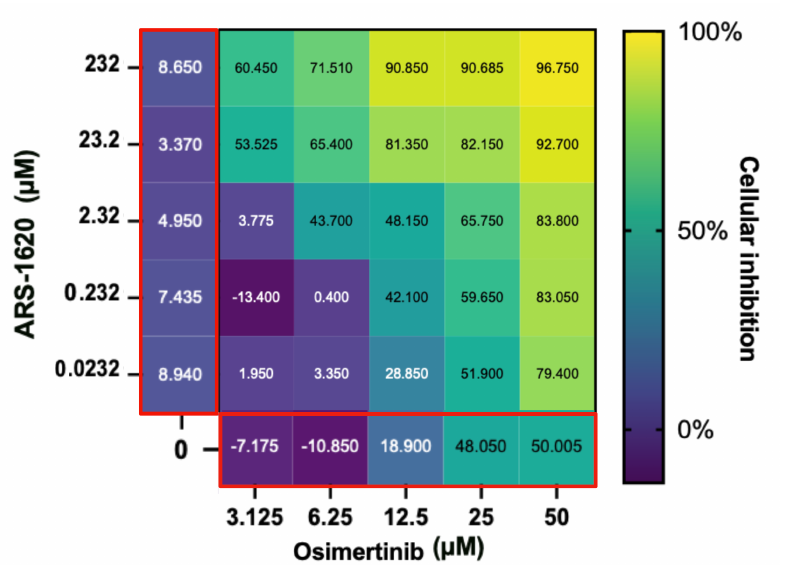
Figure 5. Evaluation of the ARS-1620 and osimertinib drug combination. The main heatmap panel outlined in black shows H1792 cell inhibition as a percentage normalized using untreated controls ranging from 0% (dark blue) to 100% (yellow) for different concentrations. ARS-1620 and osimertinib by themselves are shown on the left and the bottom, respectively, (both outlined in red). This shows that although H1792 did not respond strongly to ARS-1620 alone, a synergistic effect on cellular inhibition was observed when combined with osimertinib as hypothesised from the CANDO predictions. Created with BioRender.com.